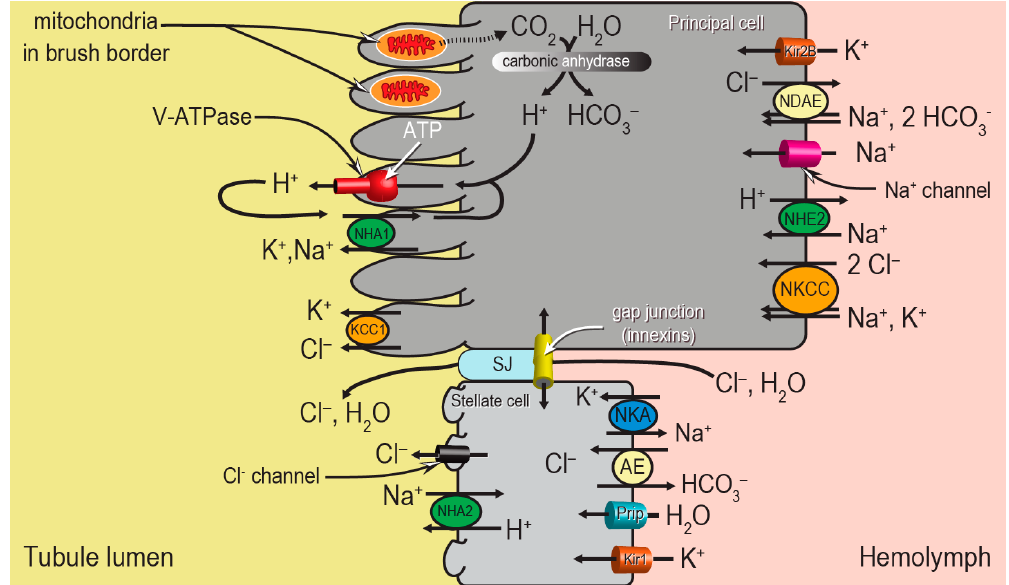
Figure 2. Model of transepithelial fluid secretion in mosquito Malpighian tubules. The transport modes of NHA1 and NHA2 are speculative. AE, Cl − /HCO 3 − anion exchanger; ATP, adenosine triphosphate; KCC, K, Cl cotransporter; Kir, inward rectifier K + channel; NDAE, Na + -driven anion exchanger; NHA, Na + /H + antiporter; NHE, Na + /H + exchanger; NKA, Na + -K + -ATPase; NKCC, Na + , K + , Cl − cotransporter; Prip, Pyroceoelia rufa integral protein (aquaporin); SJ, septate junction. Modified from [12].